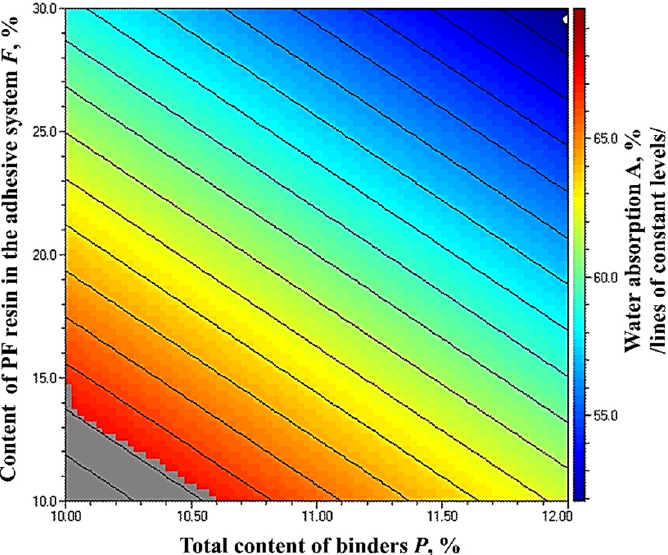
Figure 12. Effect of binder content and PF resin content in the adhesive system on WA (24 h) of fiberboard panels.